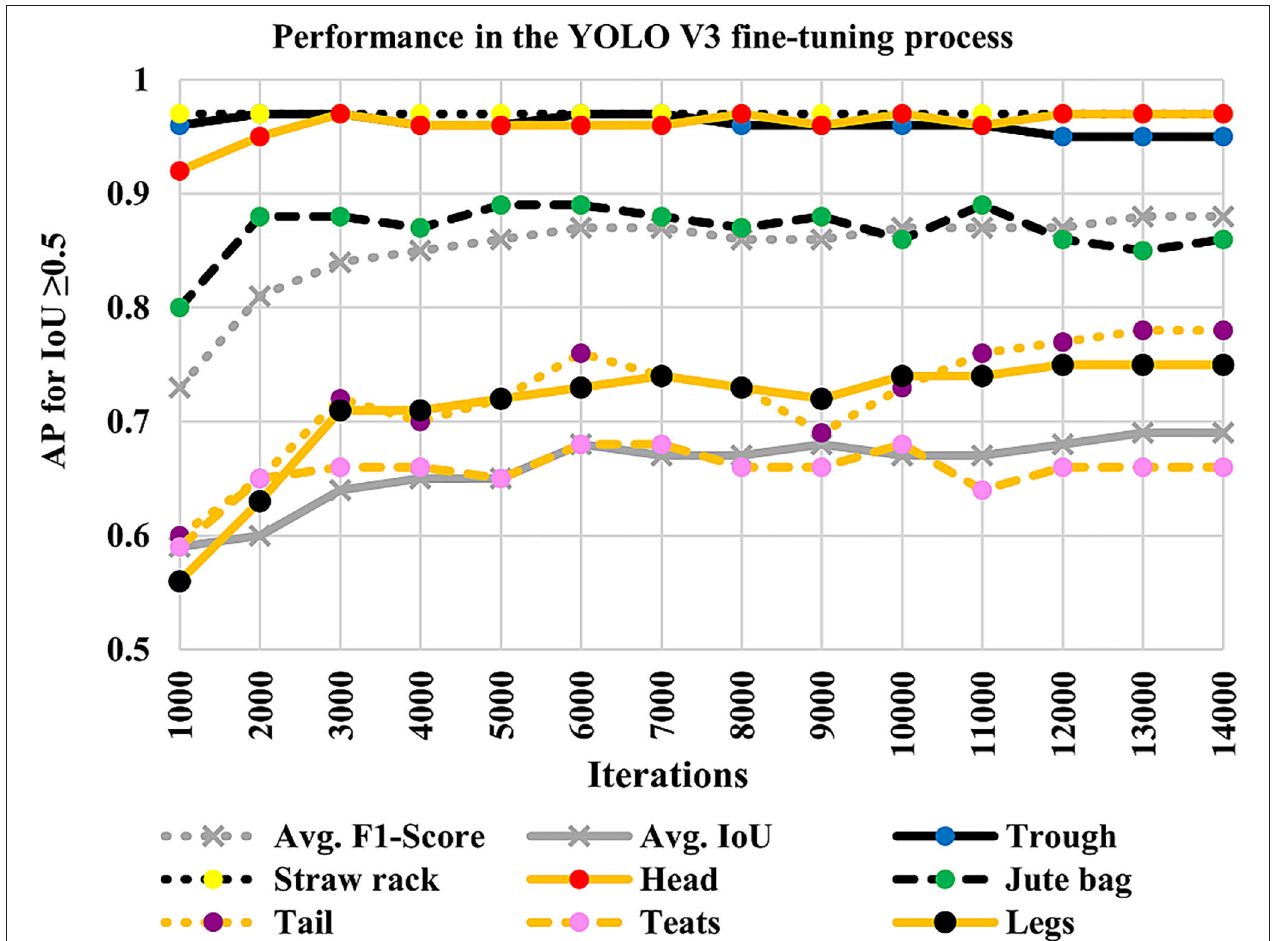
FIGURE 5 | The Average Precision (AP) of all trained classes in the YOLO V3 training/learning process with settings of intersection over Union (IoU) ≥ 0.5. After 14,000 iterations the classes straw rack, feeding trough and head are detected with an AP of 1.0–0.9. The classes jute bag and legs have an AP in the area of 0.89–0.7. Whereas, the class teats is the only class with an AP < 0.7.